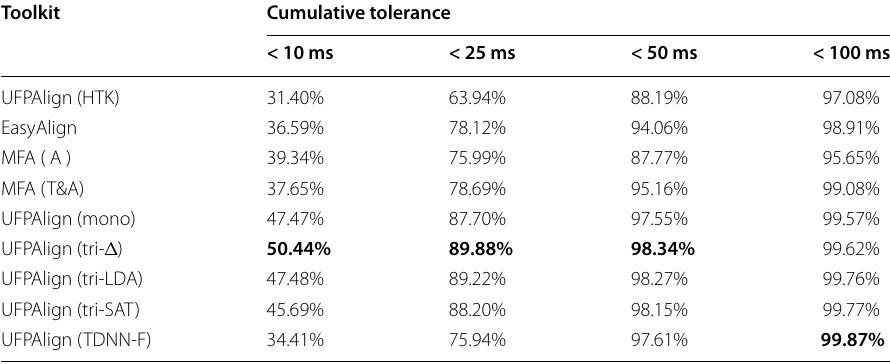
Table 10 Results for the female dataset regarding the cumulative percentage below a tolerance threshold, in milliseconds, of the differences between forced aligned audio and ground-truth phonemes, also known as phone boundary